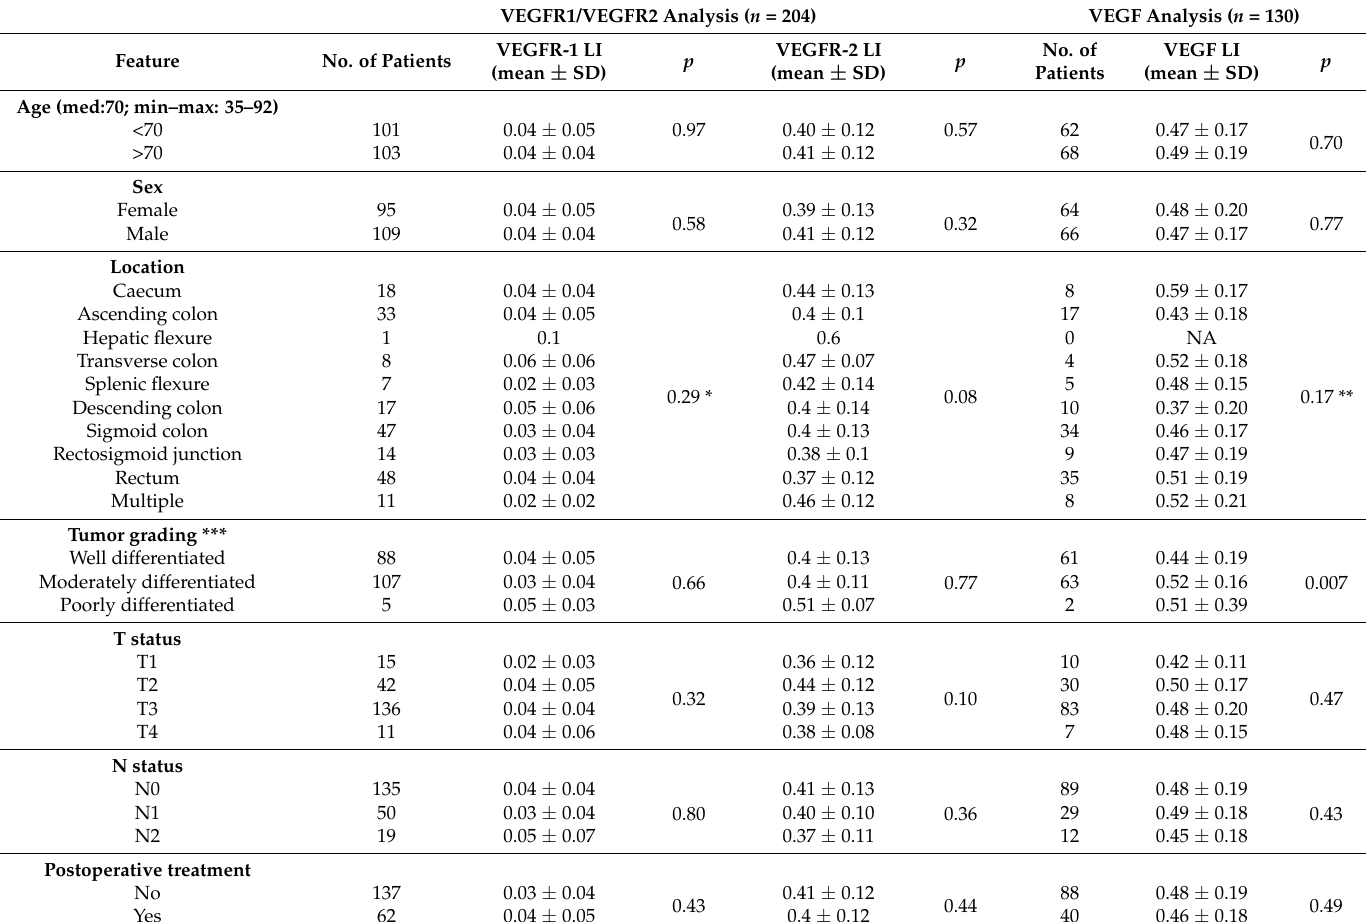
Table 1. Patient characteristics and association with endothelial cell (EC) vascular endothelial growth factor (VEGF), vascular endothelial growth factor receptor -1 (VEGFR-1) and VEGFR-2 labelling indices